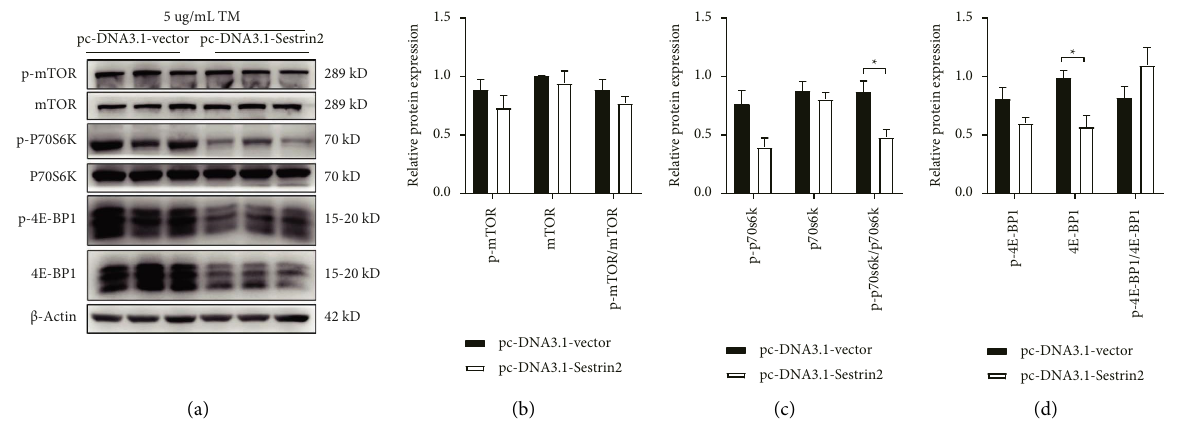
Figure 6: Sestrin2 overexpression inhibits TM-induced mTOR pathway activation. (a) Representative western-blot results of major proteins associated with mTOR pathway. (b) Statistical analysis of p-mTOR, mTOR and their ratio (unpaired two-tailed t -test; all P values > 0.05). (c) Statistical results of p-P70S6K, P70S6K and their ratio (unpaired two-tailed t -test; for p-p70s6k/p70s6k: t (4) � 3.30, P � 0 . 030). (d) Quantitative results of p-4E-BP1, 4E-BP1 and their ratio (unpaired two-tailed t -test; for 4E-BP1: t (4) � 3.62, P � 0 . 022). ∗ P < 0 .